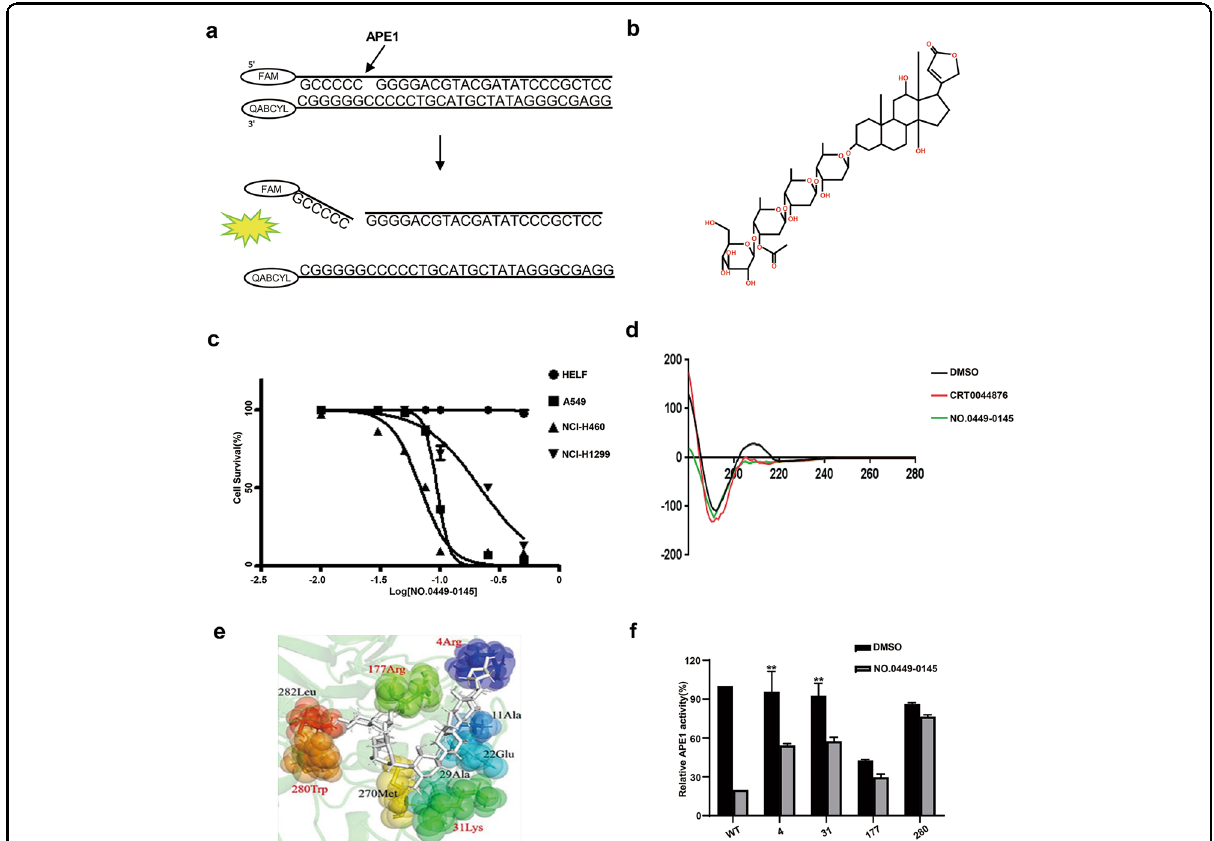
Fig. 2 Screening of small molecular inhibitor of APE1. a The schemata of AP site cleavage assay. b Chemical structure of NO.0449-0145. c Cell survival assay showed that NO.0449-0145 treatment induced cell death in A549, NCI-H460, NCI-H1299 cells but not in HELF cell. d Circular dichroism spectroscopy analysis of APE1/NO.0449-0145 binding. e Docking studies identi fi ed four high-potential sites of APE1 binding with NO.0449-0145. f Inhibitory effects of NO.0449-0145 on FEN1 mutations. Each experiment was repeated three times. ** p <